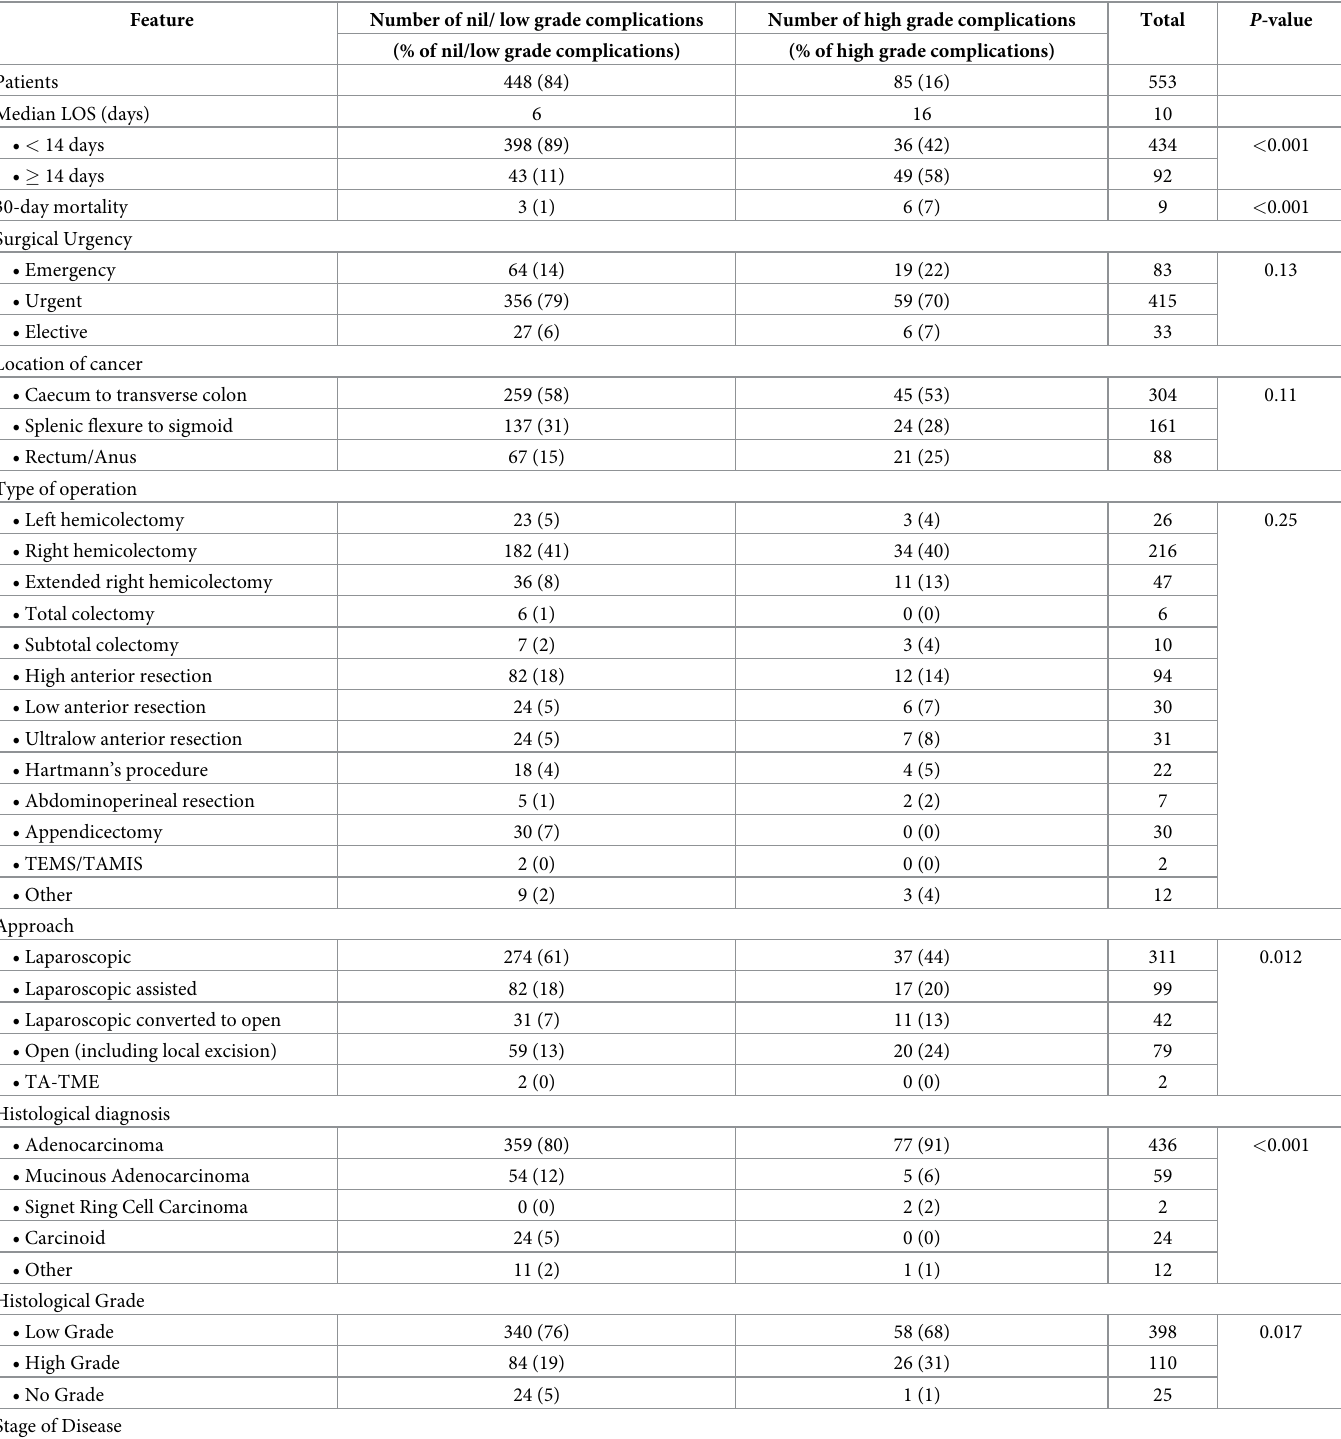
Table 2. Surgical and pathological features of patients who underwent colorectal cancer resections at The Prince Charles Hospital between 2010–2018.